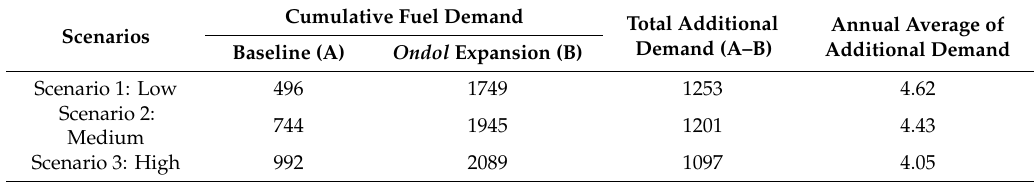
Table 5. Additional forest litter demand by scenario (unit: million ton).